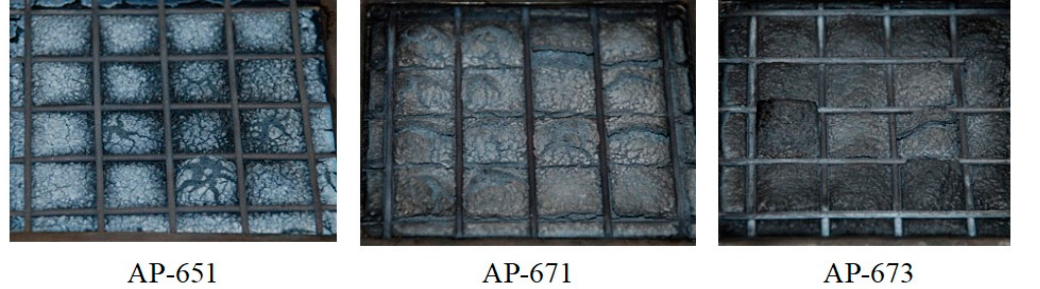
Figure 5. Heat release rate curves of AP-651, AP-671 and AP-673 as a function of burning time.